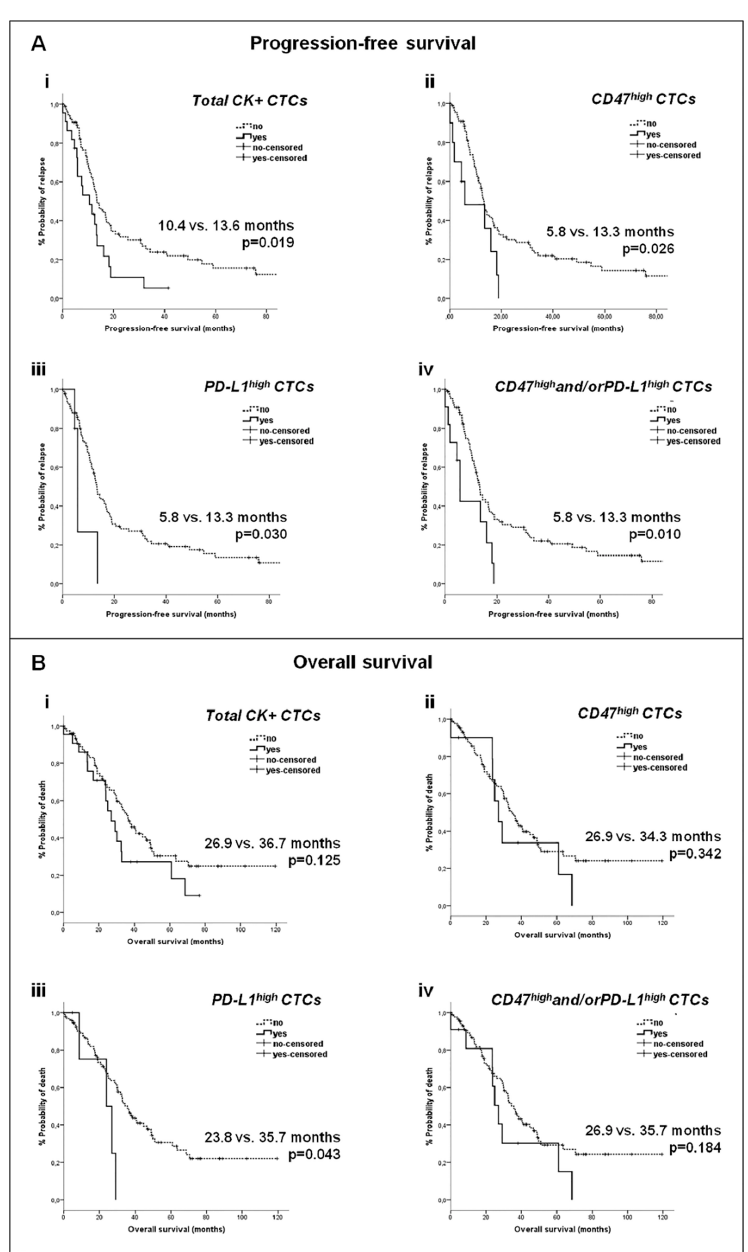
Figure 3. Survival analysis of patients with metastatic BC according to the detection and phenotype of CTCs. ( A ) Kaplan–Meier curves for progression-free survival (PFS) according to the detection of ( i )